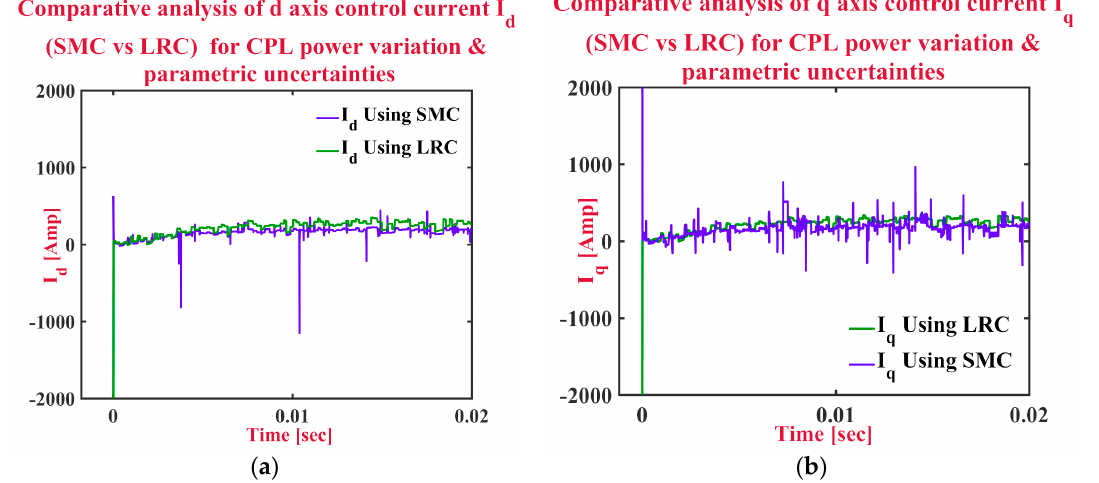
Figure 12. Comparison of performance between SMC (colored in blue) and LRC (colored in green) in case of ( a ) d-axis output voltage, ( b ) q-axis output voltage considering parametric uncertainties. LRC controller shows considerably better performance than SMC by staying closer to the reference voltage.